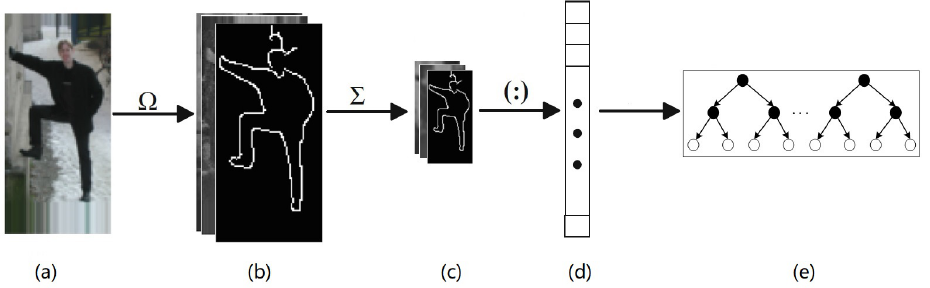
Figure 1. The flowchart of ACF. ( a ) Original color image ( b ) Extended image channels ( c ) Aggregate channels ( d ) Feature vector ( e ) Soft